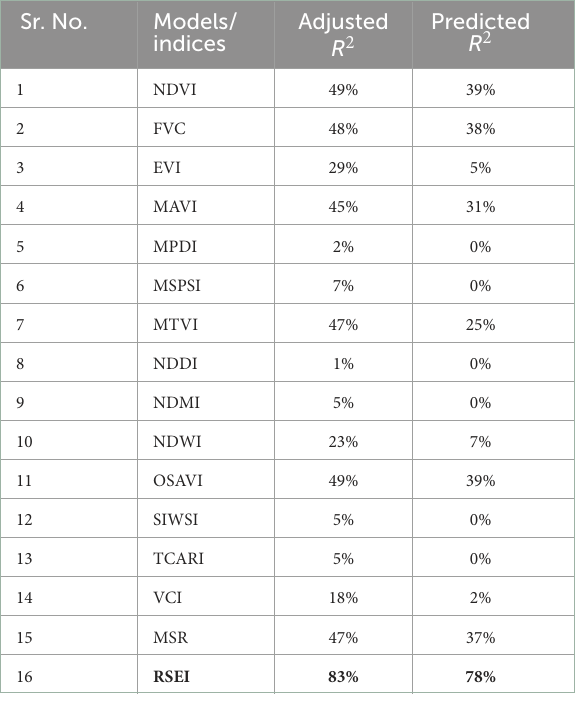
TABLE 3 Accuracy assessment of RSEI and other remote sensing indices against the crop productivity. Sr.